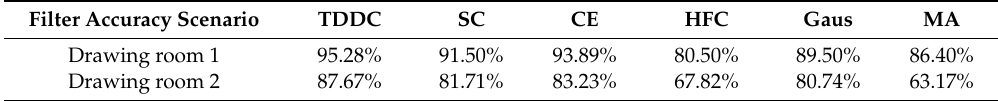
Figure 10. The classification results of the two testing samples filtered by different wavelet filter. ( a ) The testing sample was collected in drawing room 1. ( b ) The testing sample was collected in drawing room 2. Table 1 records the statistical results for the accuracy rates of multiple test groups. In the same environment and with 0.5 m resolution, the localization accuracy is higher when the RSS data is filtered by TDDC wavelet filtering. Table 1. The statistical results of the localization accuracy rates for multiple test samples filtered by different methods.